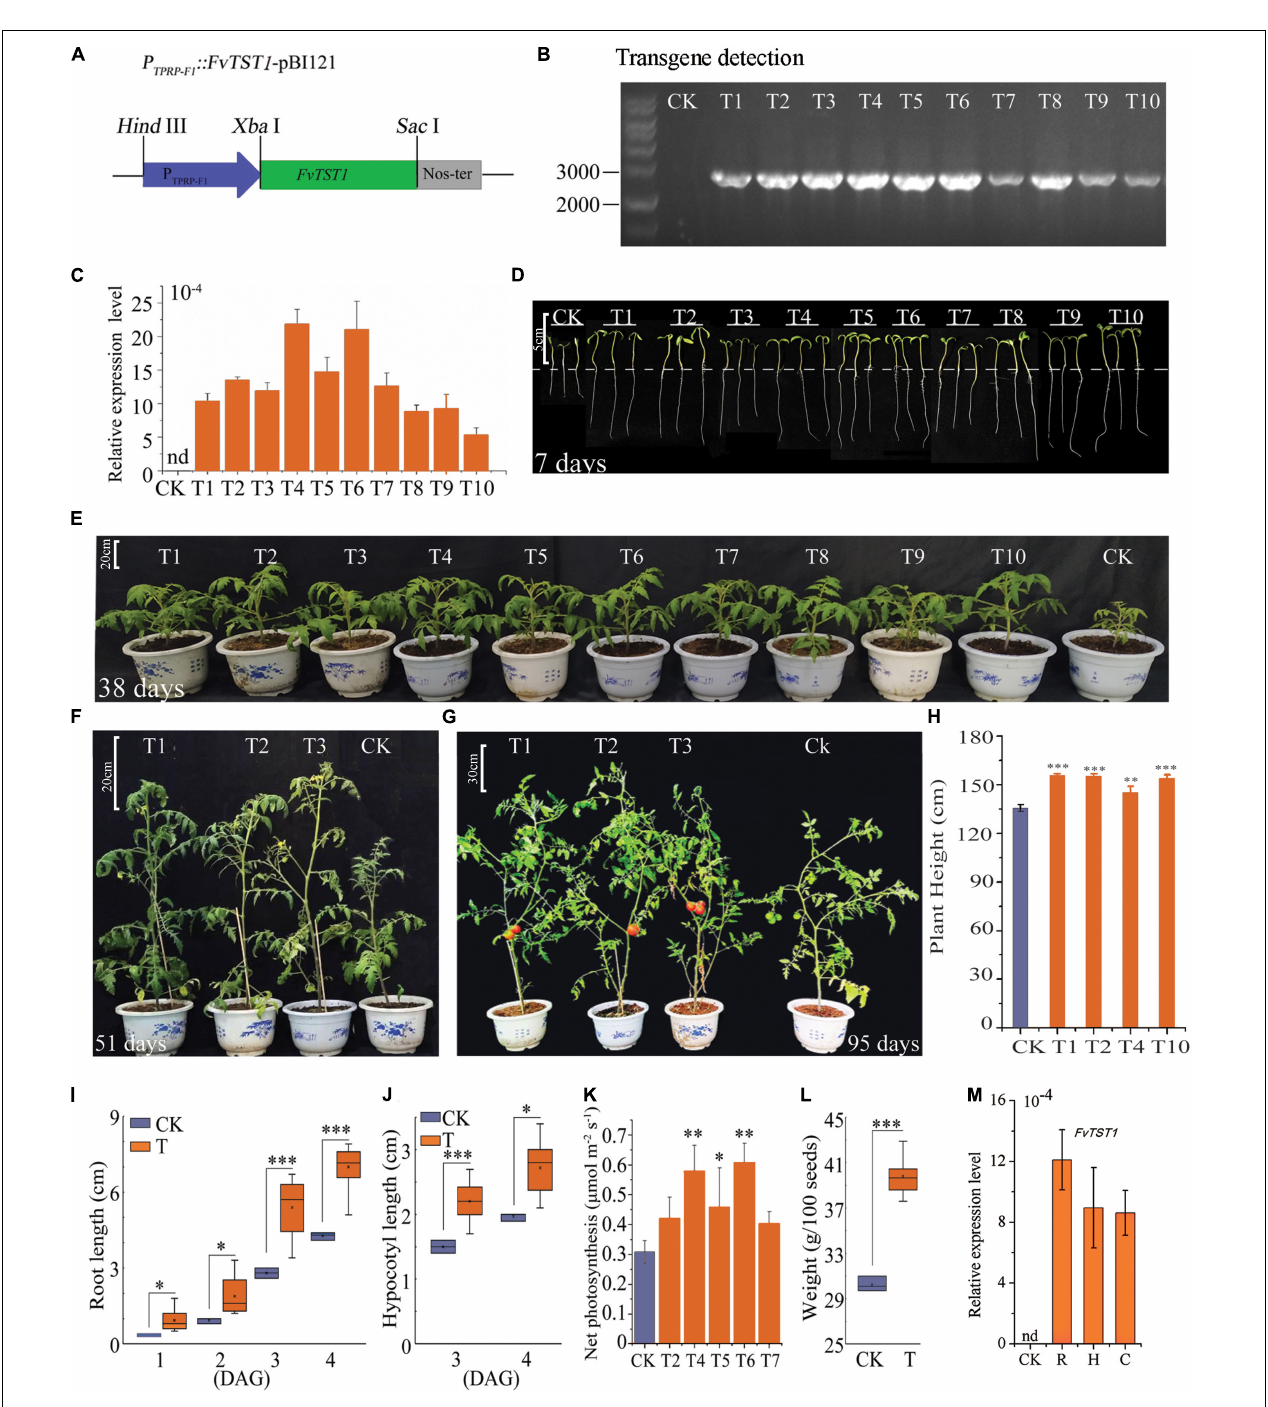
FIGURE 5 | Phenotypic alteration of FvTST1 transgenic tomato ( Solanum lycopersicum cv. Ailsa Craig+ (AC+). (A) P TPRP - F 1 ::FvTST1-pBI121 plants expression construct. (B) PCR detection of FvTST1 in transgenic plants. (C) Transcript levels of FvTST1 in transgenic and control plants. (D) Phenotypic differences among 7-day-old (4 DAG) transgenic plants (T) compared to control (CK) (Scale bar = 5 cm). (E) Enhanced growth of 38-day-old transgenic plant compared to control (Scale bar = 20 cm). (F) Phenotypes of 51-day-old transgenic plants and control (Scale bar = 20 cm). (G) Phenotypes of 95-day-old transgenic and control plants (Scale bar = 30 cm). (H) Plant height differences between transgenic plant and control. (I) Root growth of the 7-day-old (4 DAG) transgenic plants compared to control. (J) Hypocotyl growth of 7-day-old (4 DAG) transgenic plants compared to control. (K) Net Photosynthesis rate (L) Higher seed weight of transgenic tomato compared to control plants. (M) Transcript level analysis of FvTST1 in root (R), hypocotyl (H) and cotyledon (C). (CK refers to control and “T” stands for transgenic, and number represents independent transgenic line). The data were shown as mean ± standard deviation of three biological replicates. The SPSS software (v19.0) was used for one-way ANOVA ( ∗ p < 0.05 ; ∗∗ p < 0.01 ; ∗∗∗ p < 0.001).